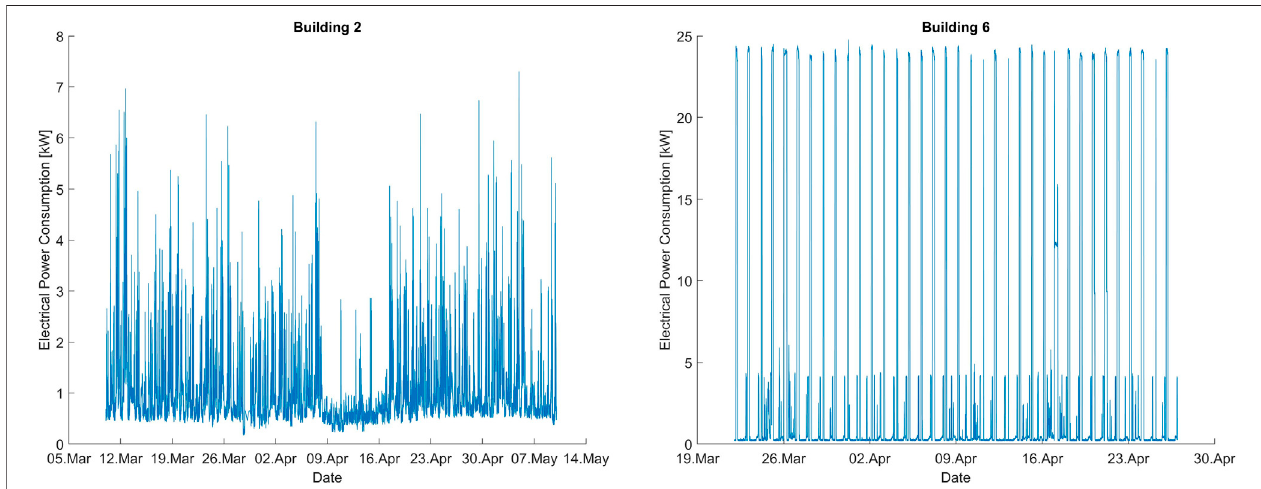
FIGURE 5 | Measured electricity consumption of case study building two (left) and case study building six (right) .